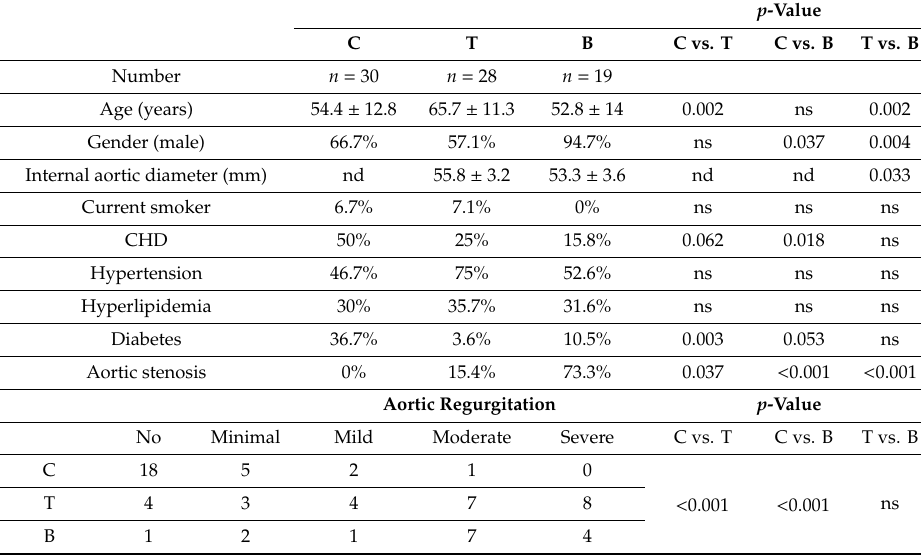
Table 1. Clinical characteristics of controls and aneurysm